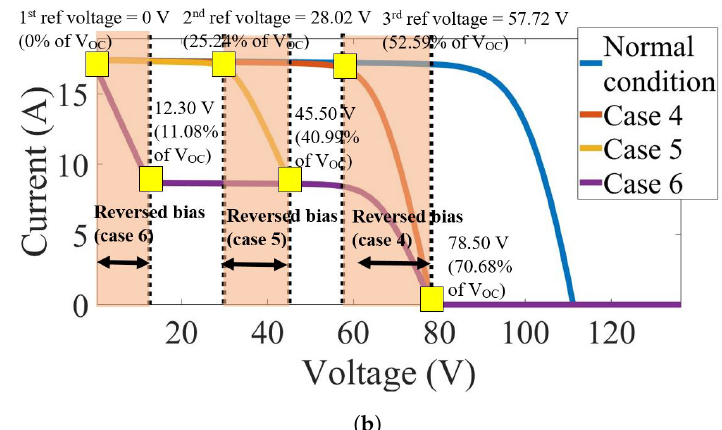
Figure 7. I–V characteristic curve for the hotspot PV array: ( a ) series-connected (case 1–3), and ( b ) parallel-connected (case 4–6).